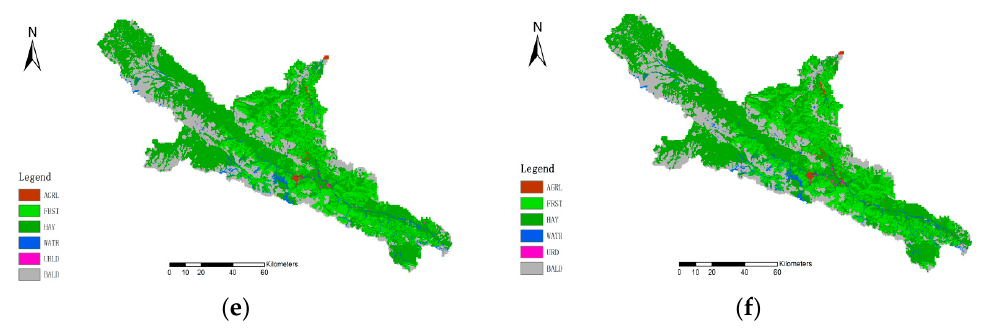
Figure 8. Distribution of land use types under different simulation scenarios. ( a ) Natural growth scenario in 2020, ( b ) Natural growth scenario in 2030, ( c ) Ecological protection scenario in 2020, ( d ) Ecological protection scenario in 2030, ( e ) Economic development scenario in 2020, ( f ) Economic development scenario in 2030.